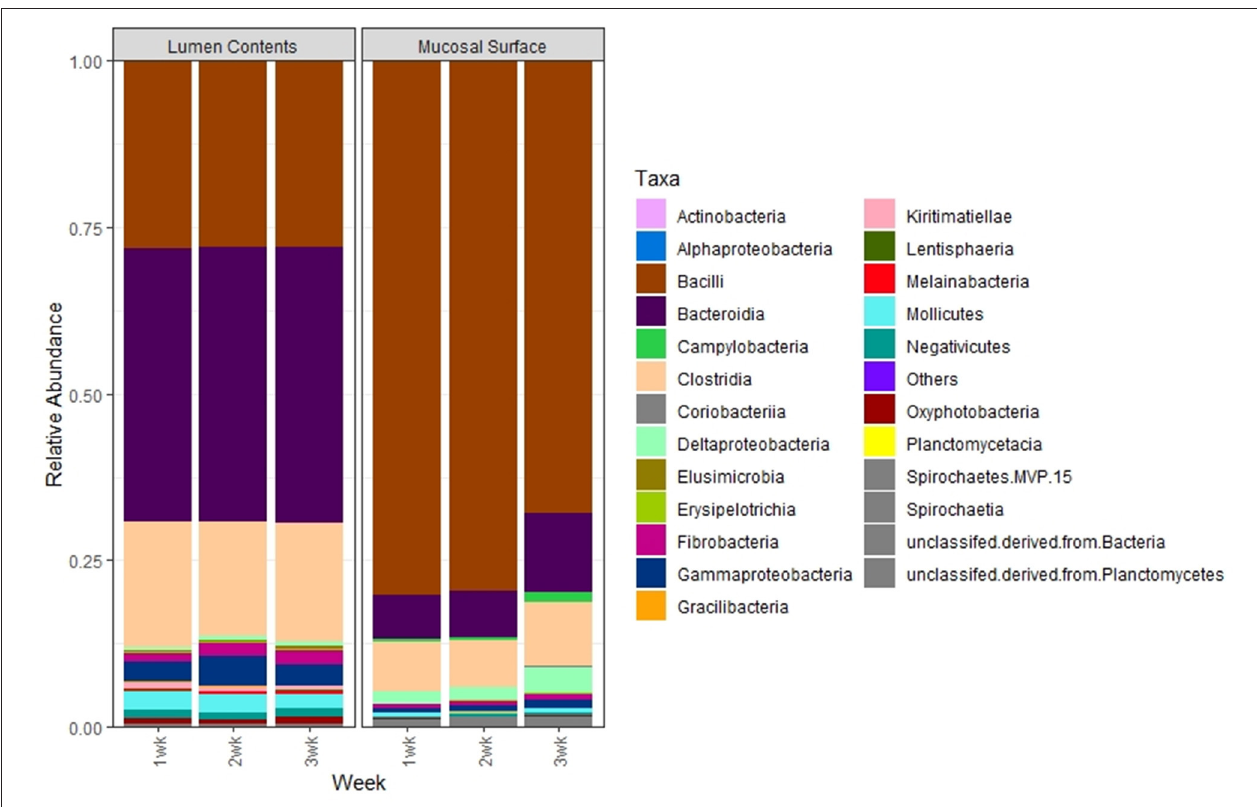
FIGURE 7 | Bacterial class. Stacked bar chart representing the average abundance of the microbiota at the class taxonomic level in the mucosal biopsy surface and lumen contents across the sampled weeks.